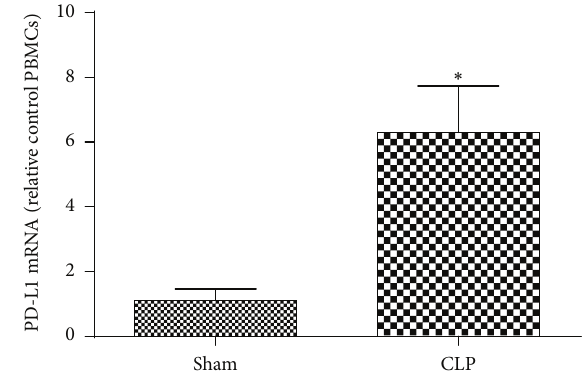
Figure 2: PD-L1 mRNA was unregulated liver of septic mice livers versus Sham at 24 hours. 𝑛 = 8 per each group. ∗ 𝑃 < 0.01 when mice with CLP were compared with mice from sham group. Bars represent the mean ± SD.